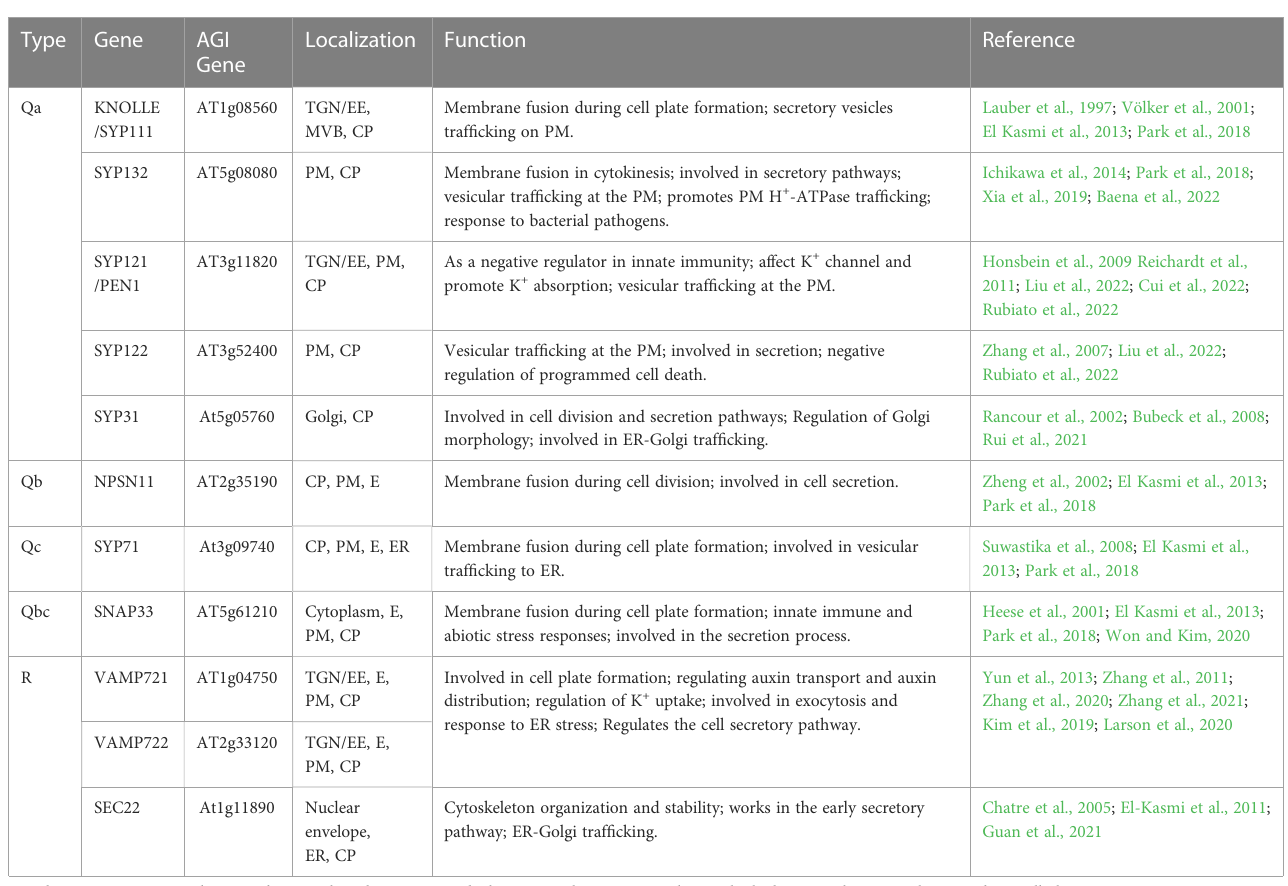
TABLE 3 Characteristics of SNAREs located in cell